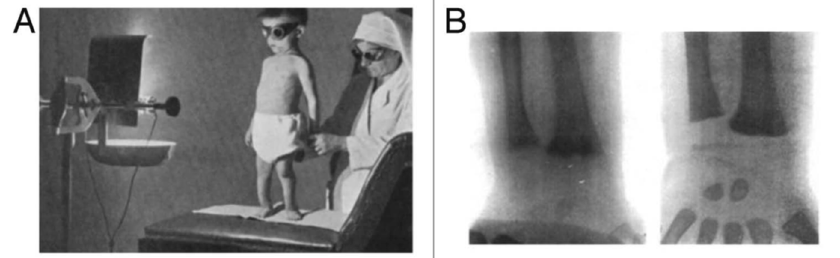
Figure 4. UV radiation therapy for rickets. ( A ) Photograph from the 1920s of a child with rickets being exposed to UV radiation. ( B ) Radiographs demonstrating florid rickets of the hand and wrist (left) and the same wrist and hand taken after treatment with 1 h UV radiation 2 times per week for 8 weeks. Note mineralization of the carpal bones and epiphyseal plates (right). Ref. [7] Holick, copyright 2006. Reproduced with permission.